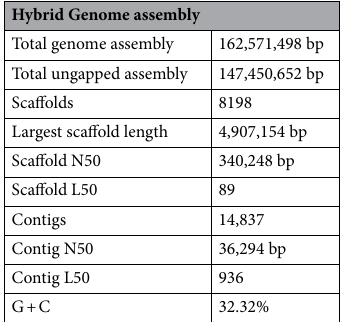
Table 1. Hypothenemus hampei genome assembly (CENICAFE_Hham1.1)